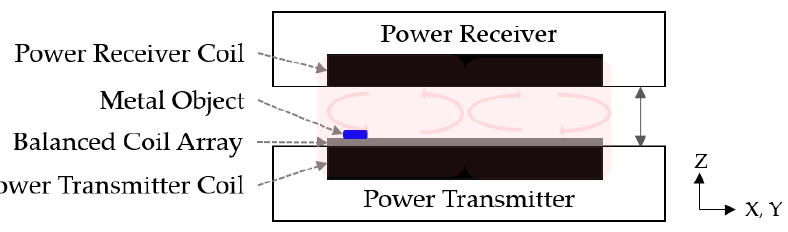
Figure 3. A cross-section of the system.